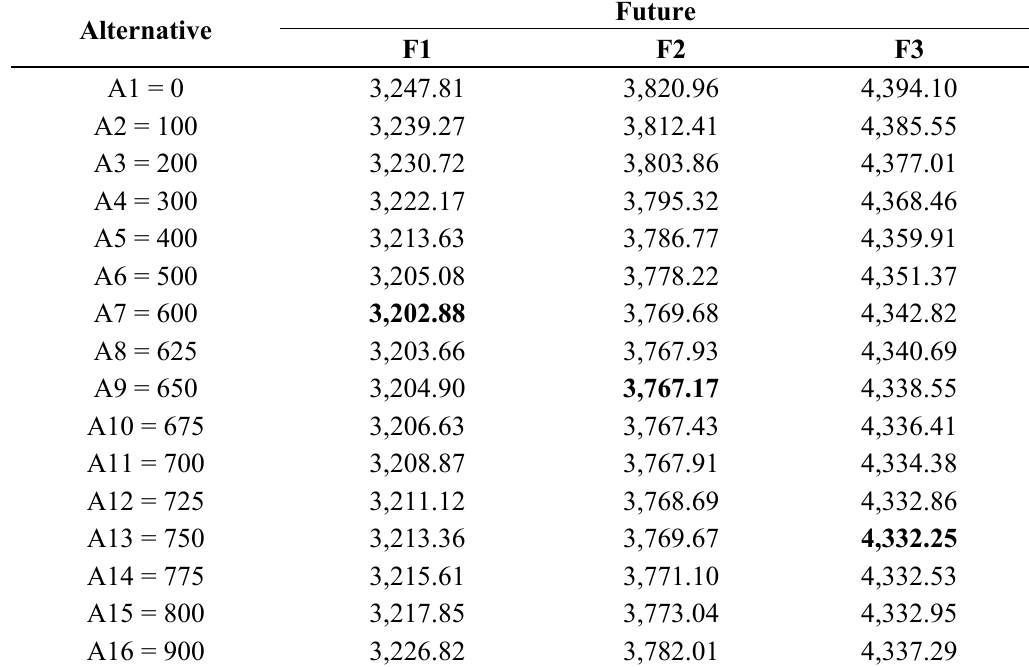
Table 1. Decision matrix: total cost (k$)—Case